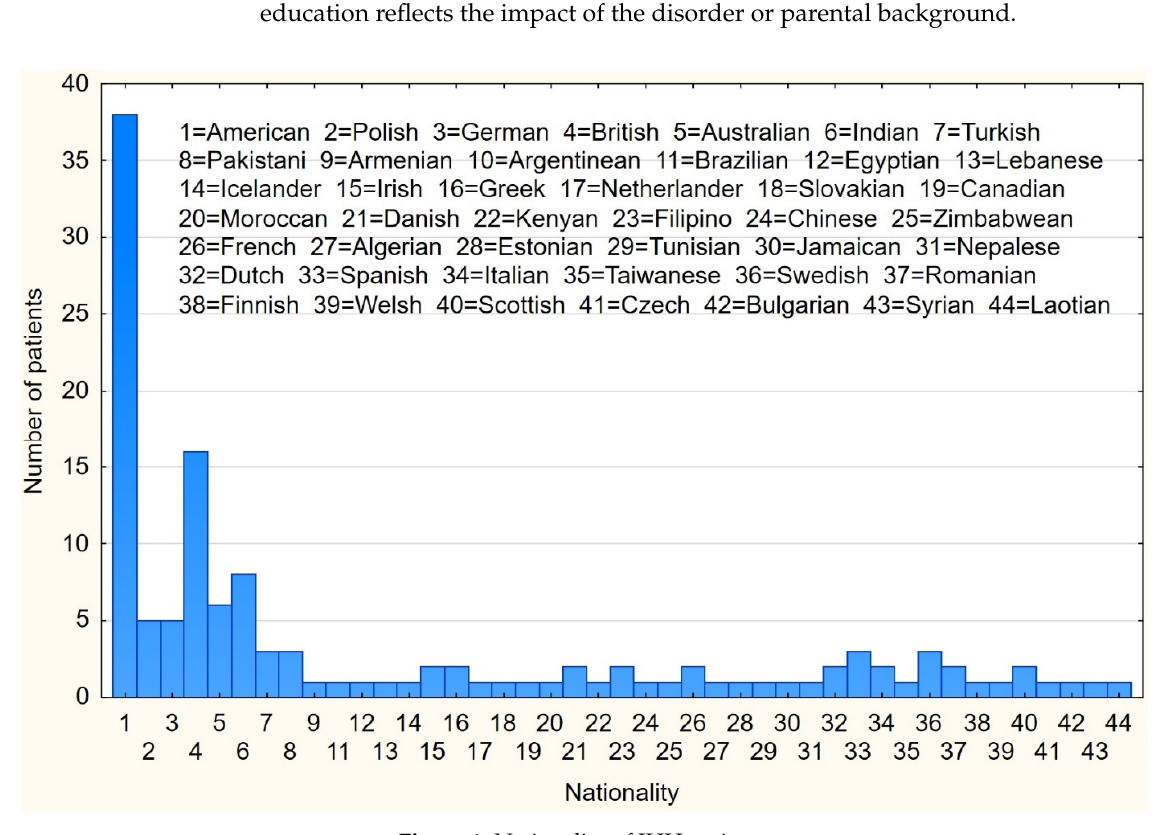
Figure 1. Nationality of IHH patients. Table 1. Sociodemographic data and characteristics of IHH patients ( n = 132) and control subjects ( n = 132).